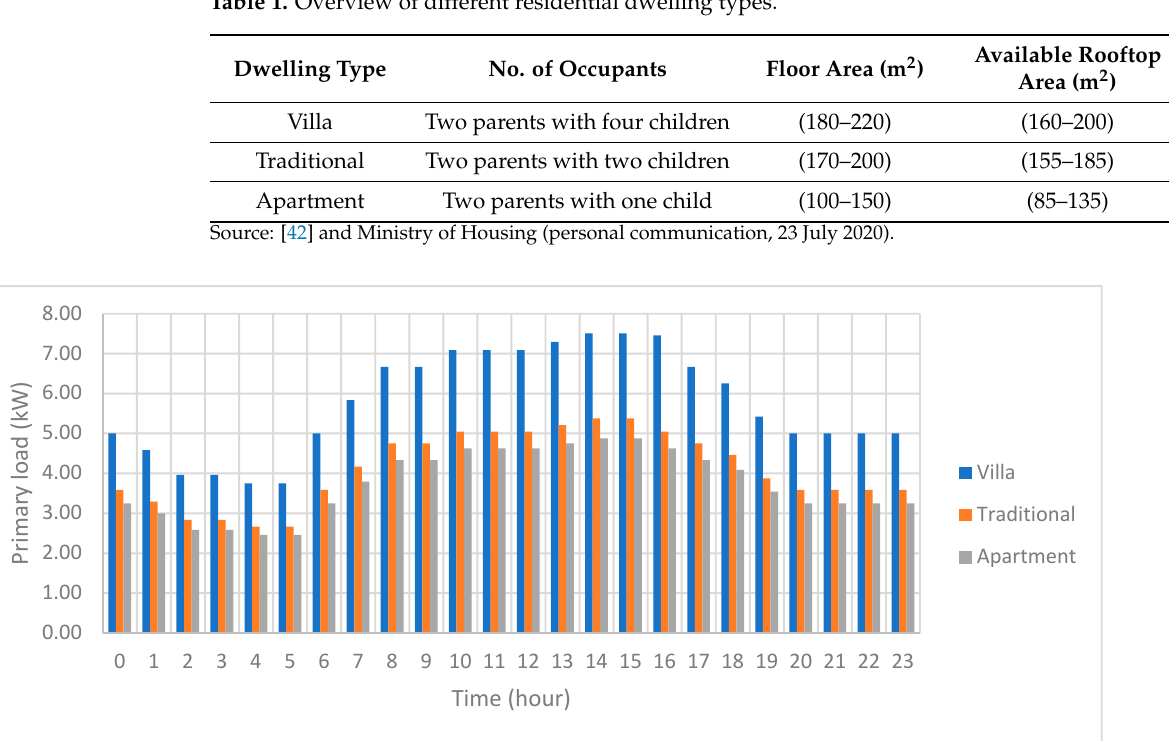
Figure 3. Hourly average electricity load profile for different types of residential buildings. Source: SEC (Personal Communication 30 June 2020).